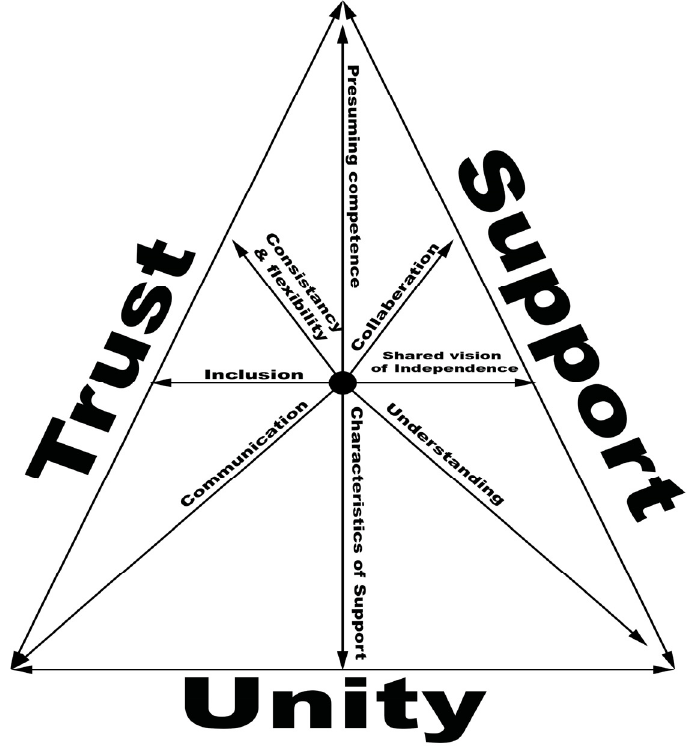
Figure 1. Dynamic model of supportive